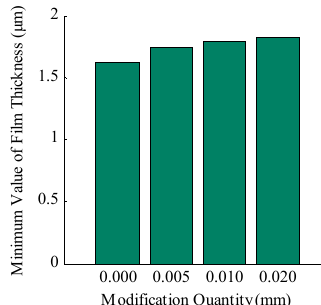
Figure 4. The minimum film thickness with different modification quantities of Case 4 (Reprinted with permission from [43]. Copyright 2018 SAGE).